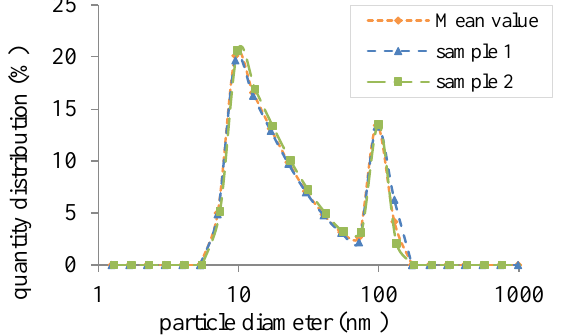
Figure 13. Quantity distribution of the Ag-H 2 O nanofluid after